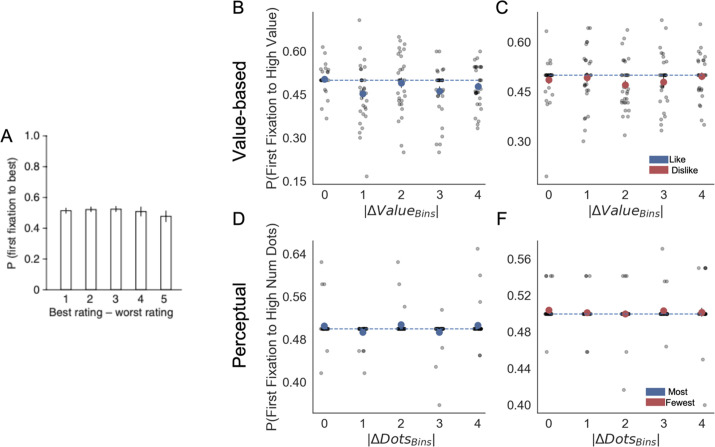
Fixation properties: probability that the first fixation is to the best item.(A) Krajbich et al., 2010 reported that the probability is not significantly different from 50%, unaffected by the difference in ratings or difficulty (in our experiments difficulty is equivalent to the absolute difference item value, |ΔValue|, and absolute difference in number of dots, |ΔDots|). A similar pattern emerges in our Value Experiment, for like (B) and dislike (C) frames, and Perceptual Experiment, for most (D) and fewest (F) frames. Participant responses did not diverge from chance. Importantly, while in Krajbich et al., 2010 participants can see both alternatives from the beginning of the trial, our presentation was gaze contingent. Segmented blue line indicates chance level. Light grey dots correspond to individual participants’ probability of first fixation to high value/number of dots alternatives for each bin. Red or blue circles indicate the average for that bin considering all the participants. Panel A reproduced from Krajbich et al., 2010.